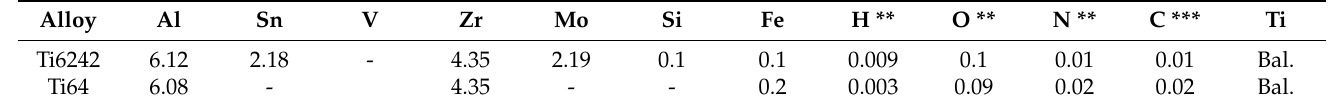
Table 1. Chemical composition of the Ti6242 and Ti64 base metals (BMs) (wt.%) *.